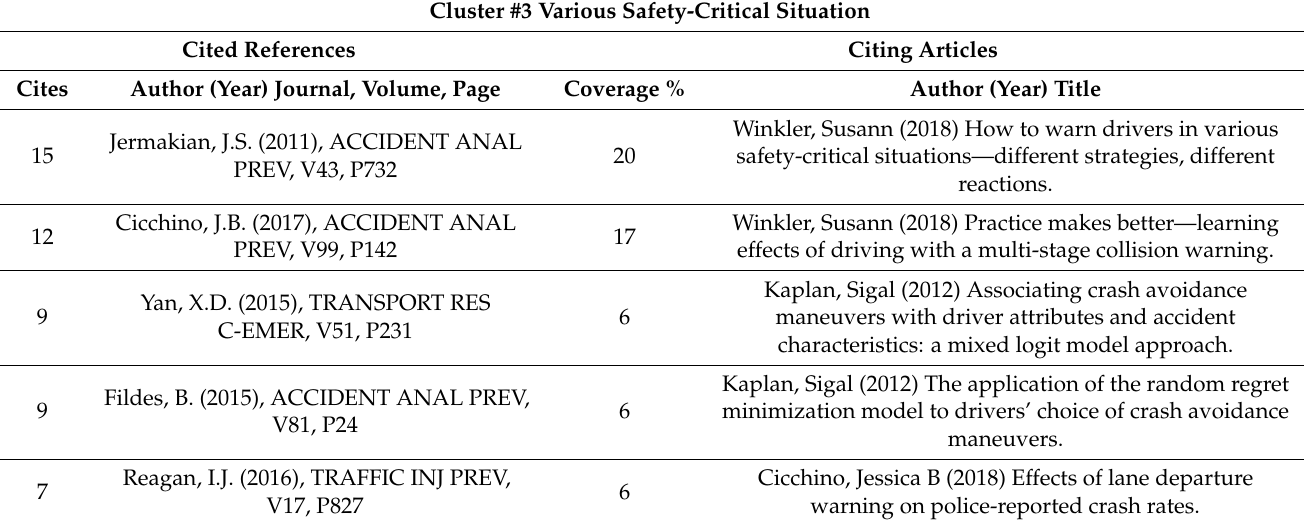
Table 4. Cited references and citing articles of Cluster